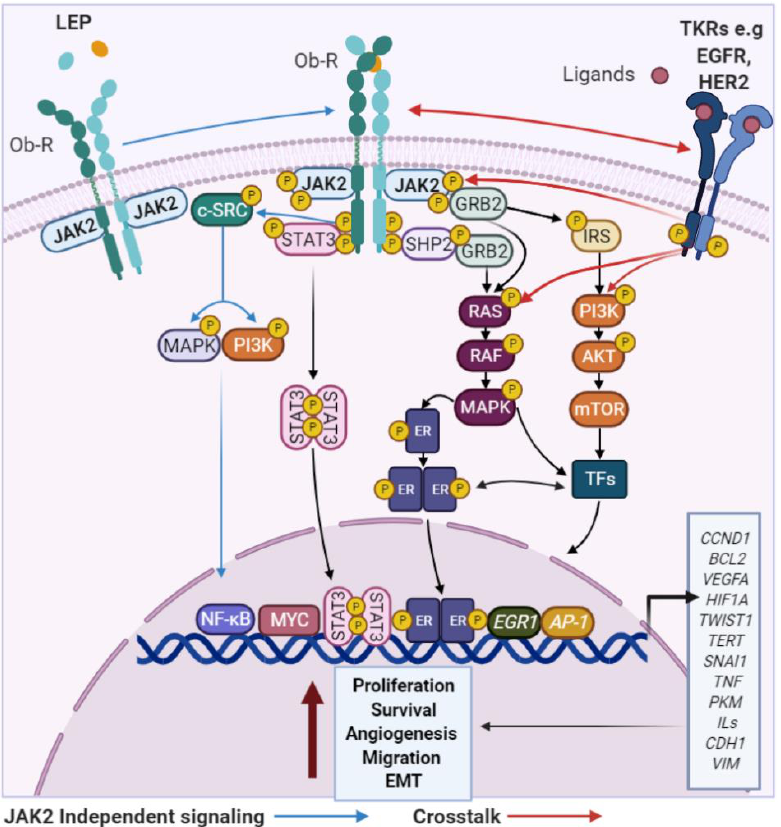
Figure 3. LEP effects in BC cells. LEP and Ob-Rs activate classical signaling pathways to regulate the expression of genes related to increased BC development independently of the ER status.